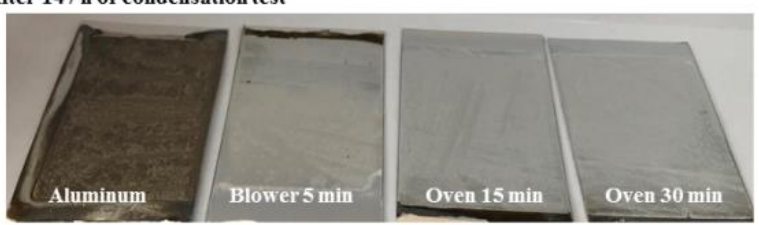
Figure 12. Photographs of bare Al and Al/SiO 2 samples before and after 147 h of condensation test. The hemispherical reflectance spectra of Al/SiO 2 preheated before applying the sil- ica layer together with bare aluminium preheated and heated (simulating the sintering treatment of the SiO 2 layer) are plotted in Figure 13. The preheating treatment of the different SiO 2 sintering conditions. Furthermore, better results regarding durability in